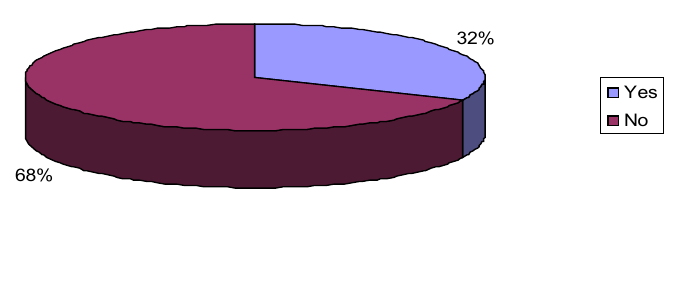
Figure 2 . Teaching staff training on ODeL